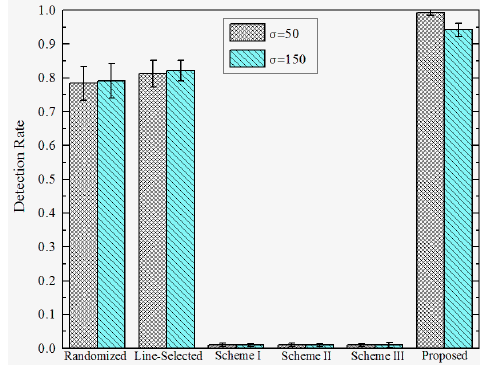
Figure 8. Detection rate of proposed versus prior works under attack strategy I when D = 200.